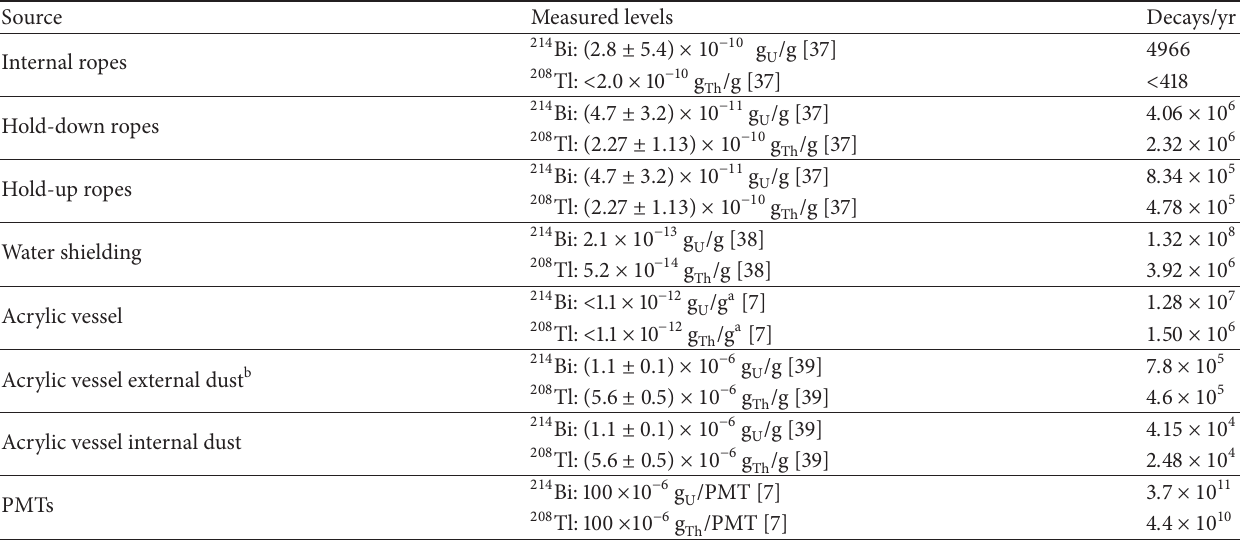
Table 3: 238 U- and 232 Th-chain levels for external background sources. Shown are measured levels and expected decay rates. Source